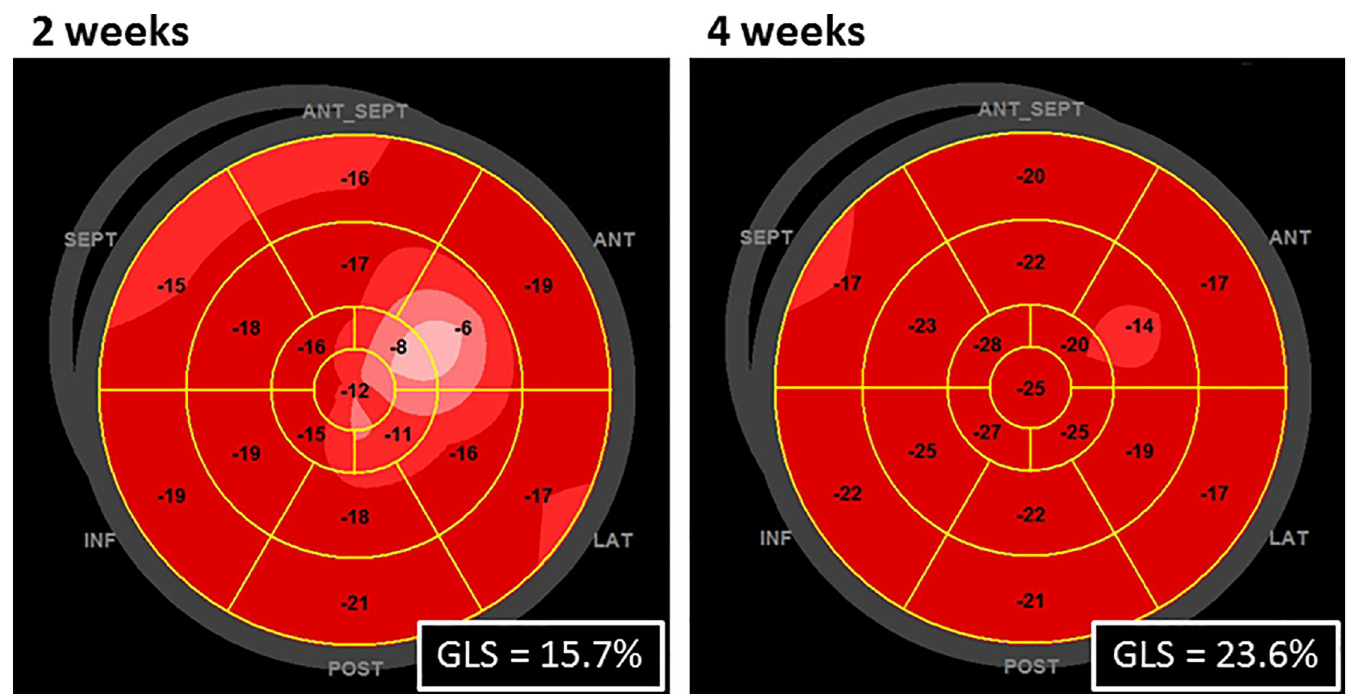
Fig 5. Bull’s eye GLS display for each LV segment for the patient as in Fig 3.